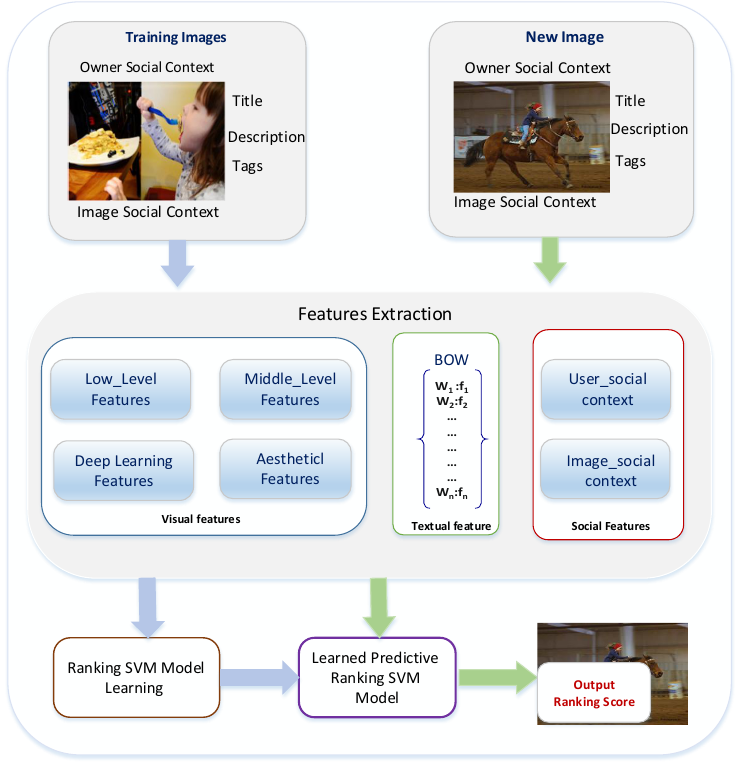
Figure 6. The framework for predicting